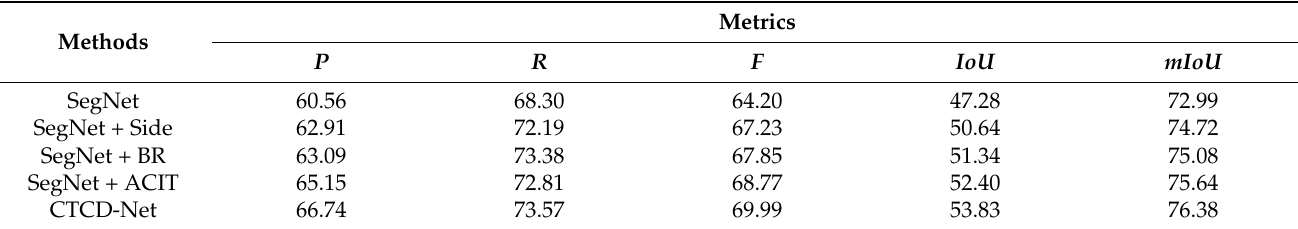
Table 5. Results of ablation